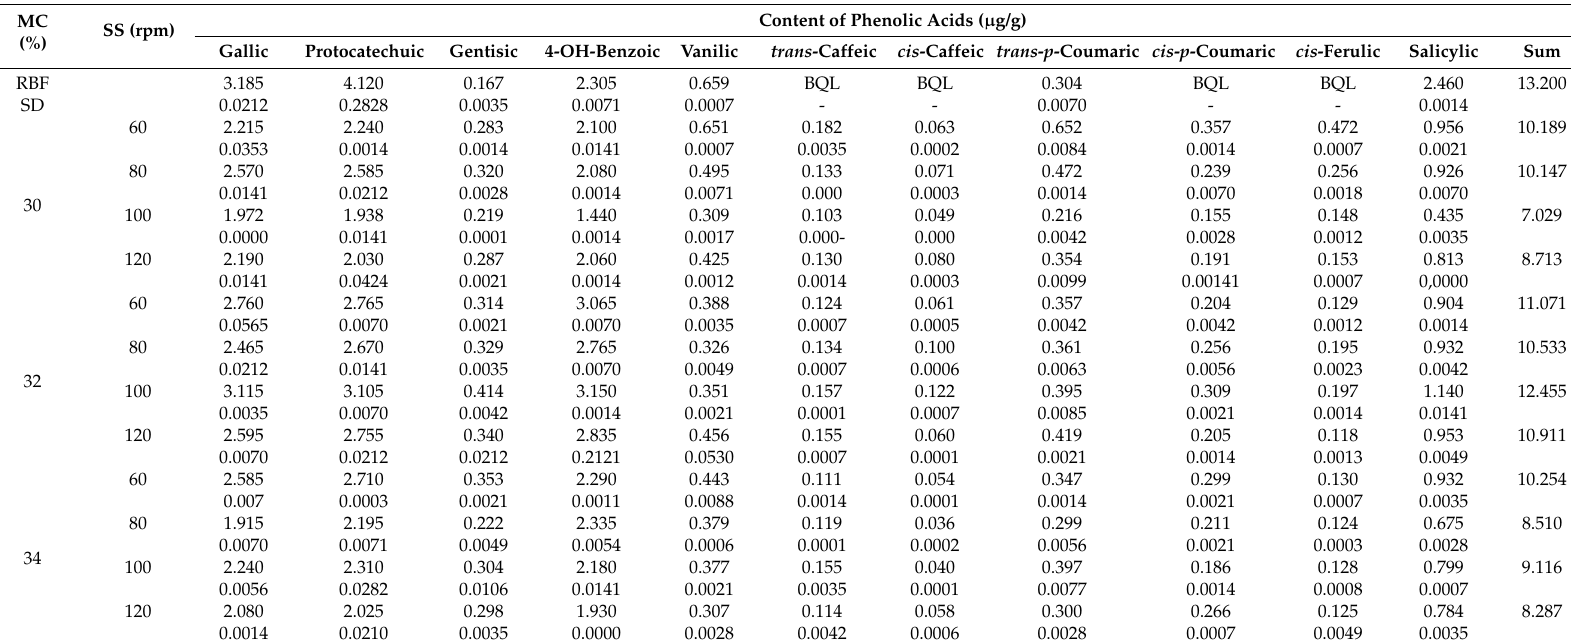
Table 2. Content of phenolic acids in gluten-free precooked buckwheat pasta (n = 3, mean ±